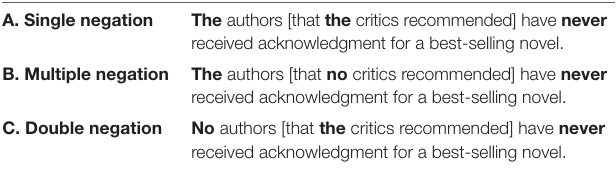
TABLE 1 | Sample set of experimental